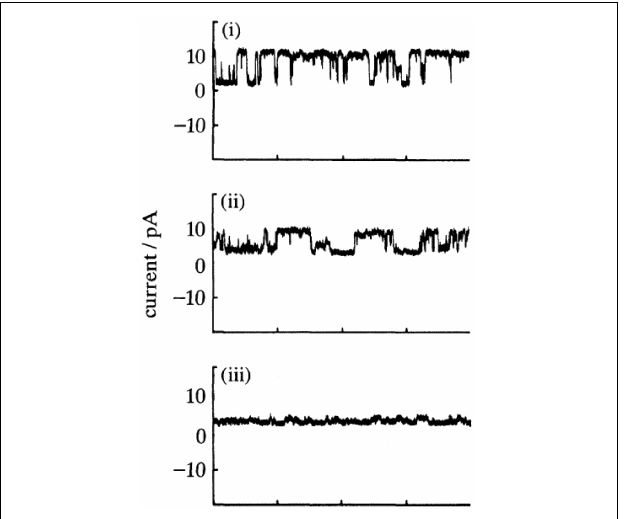
FIGURE 3 | Current fluctuations across PETP nuclear filters. Filter was bathed in 0.1 M KCI, 0.005 M HEPES pH 7.4 (i) without or (ii) with 3 × 10 − 4 M or (iii) with 3 × 10 − 3 M. From Lev et al. (1993).